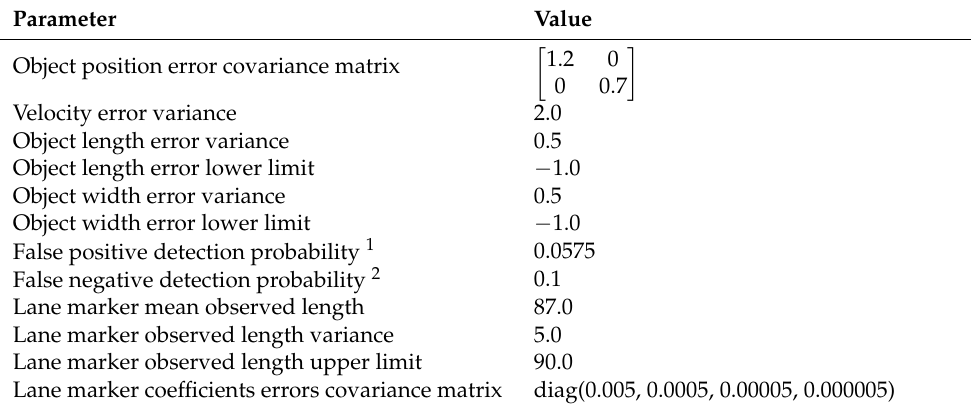
Table A5. Parameters of baseline sensor models (G-SM).